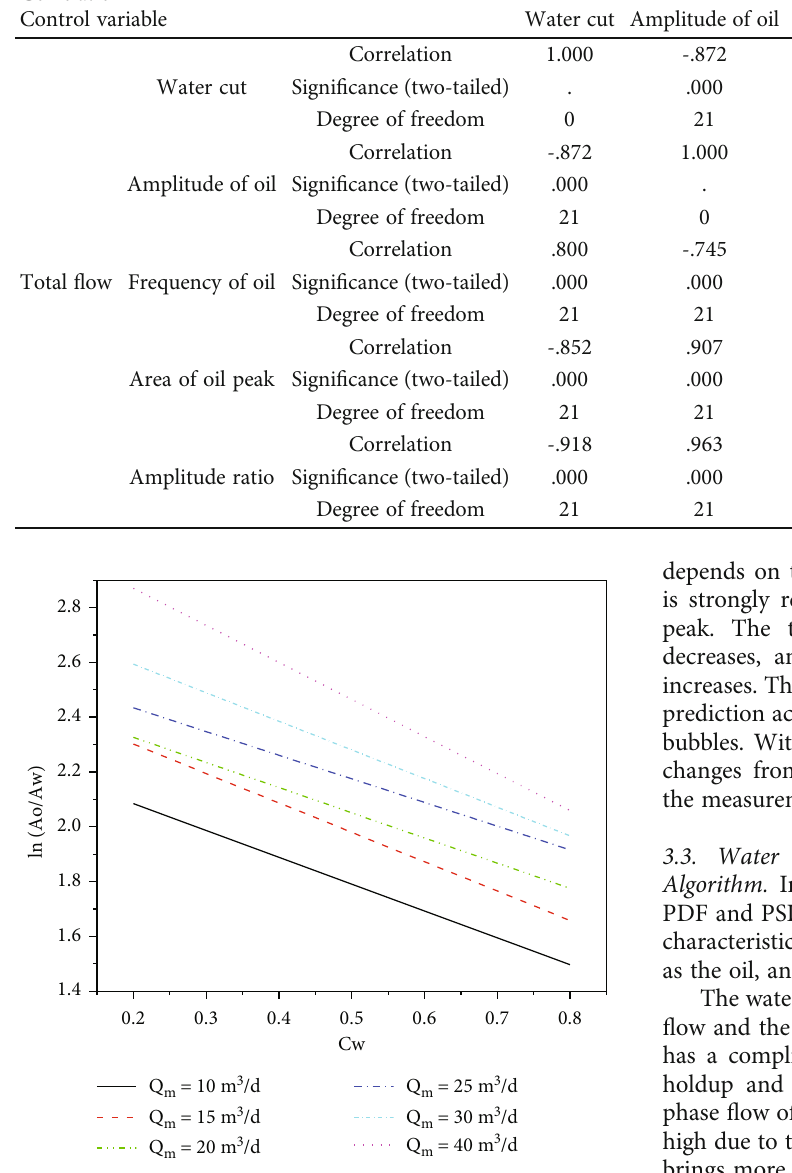
Figure 9: The relationship between water cut and amplitude ratio at the same total fl ow